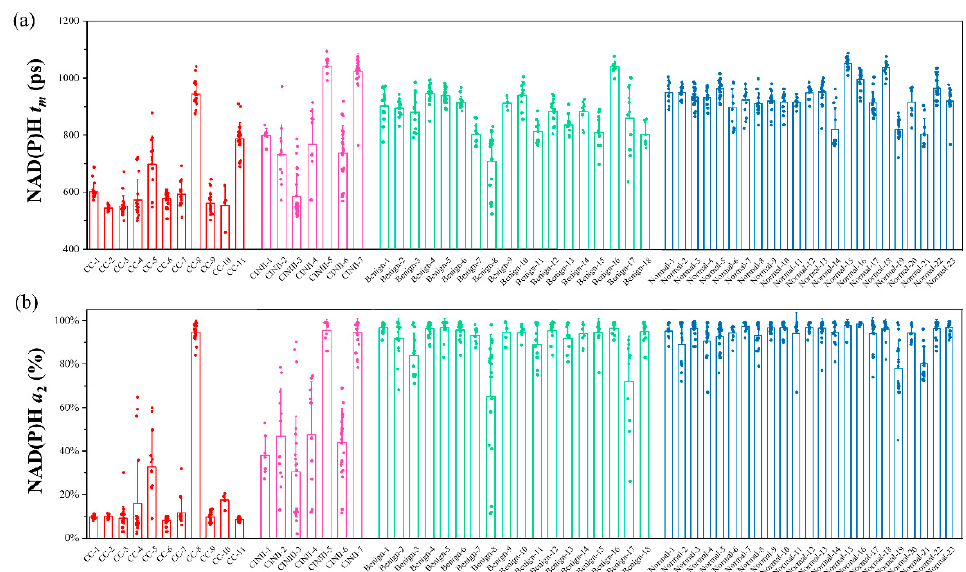
Figure 2. Statistical FLIM data of exfoliated cervical cells from the CC (n = 11), CINII/III (n = 7), benign (n = 18), and normal (n = 23) groups. ( a ) The average fluorescence lifetime ( t m ) of NAD(P)H of cervical cells based on the peak values of the FLIM distribution curves. ( b ) The protein-bound NAD(P)H proportion ( a 2 ) of cervical cells based on the peak values of the FLIM distribution curves. Each column represents one participant, and each circle represents one FLIM image data.